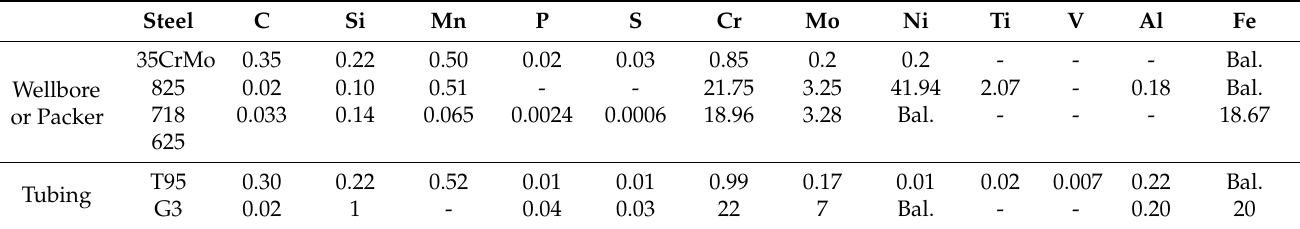
Table 2. Chemical composition of N80 and 3Cr steels (wt.%).